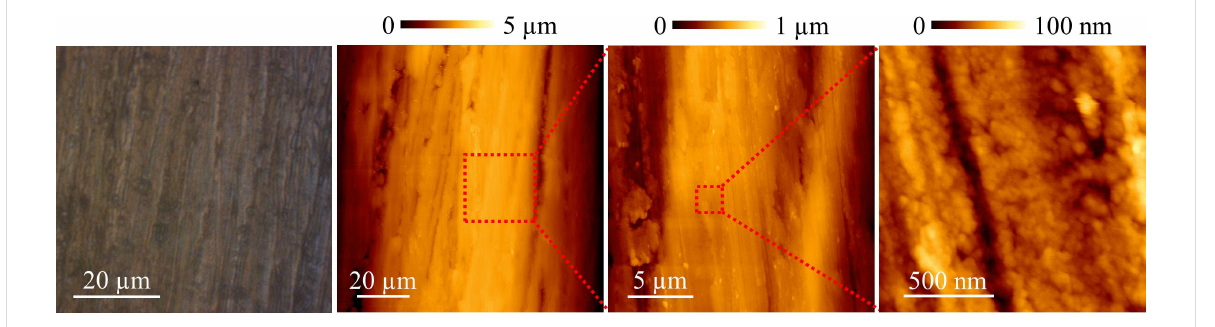
Figure 5: Surface characterization of the D-string of a violin.